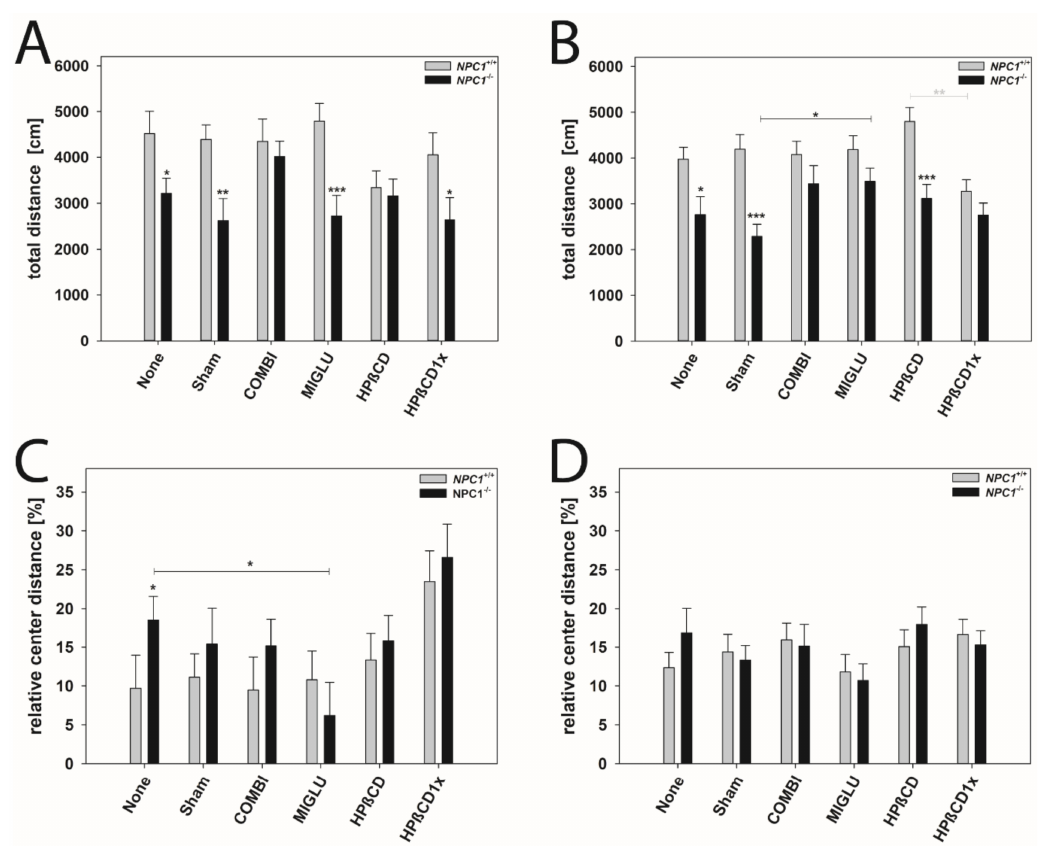
Figure 7. Open field test revealed differences in locomotoric activity ( A , B ) and anxiety-related behavior ( C , D ). Male ( A , C ) and female ( B , D ) NPC1 mice. Significant post hoc-tests are indicated by asterisks (* p < 0.05, ** p < 0.01, *** p < 0.001). Data are means ±